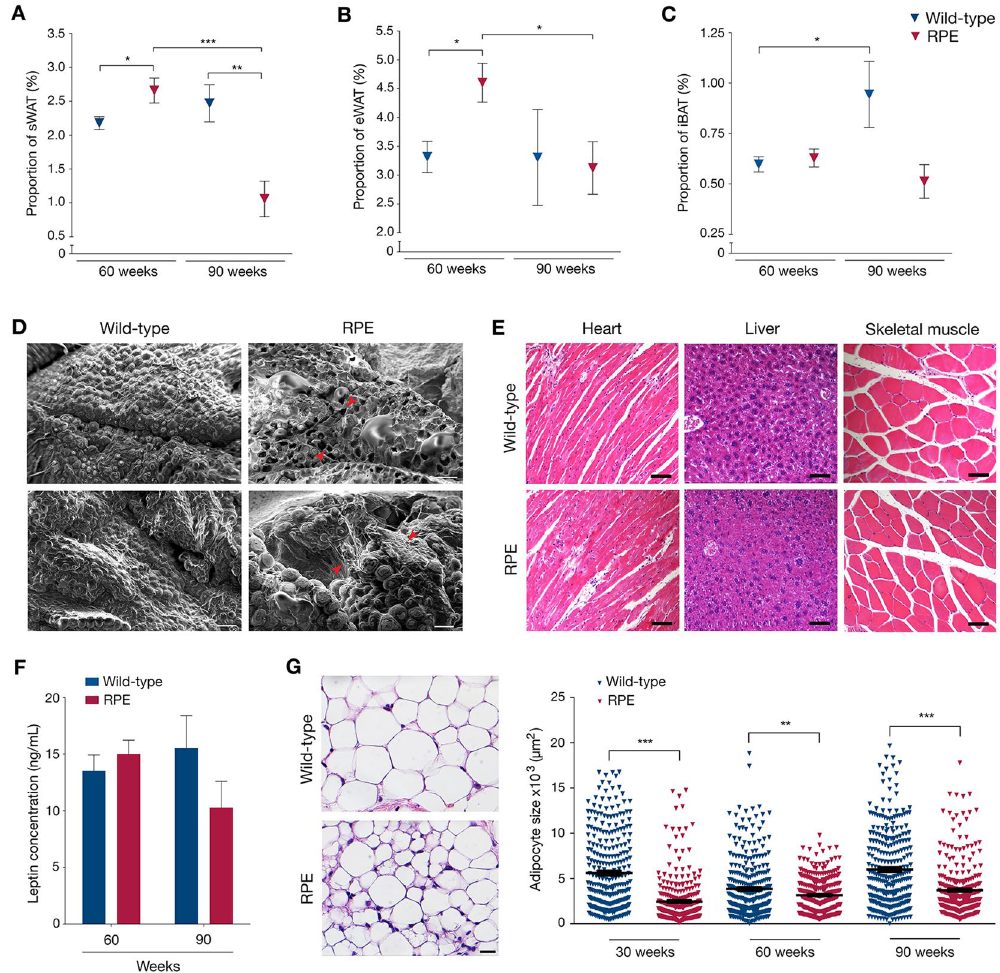
Figure 3. Loss of adipose depots with aging and phenotypic observations. ( A – C ) Weights of sWAT ( A ), eWAT ( B ) and iBAT ( C ) depots normalized to body weights of wild-type and RPE animals. ( D ) Representative SEM micrographs of 90-week wild-type and RPE mice, exhibiting adipocyte loss and tissue fibrosis. Red arrows indicate sites of anomaly. ( E ) Histological staining of heart, liver and skeletal muscle showing no accumulation of lipid droplets in either control or RPE mice. ( F ) Graph representing the concentration of circulating leptin at both 60 and 90 weeks of age in either wild-type or RPE mice, as assessed by ELISA. ( G ) Example of HTX staining from 30-week-old wild-type and RPE sWAT, used to estimate average adipocyte surface area (left). Graph representing the adipocyte area of all counted cells in sWAT of 30-, 60- and 90-week old animals (right). Scale bars: D = 100 μ m, E = 5000 μ m, F = 100 μ m. Data are represented as mean ±